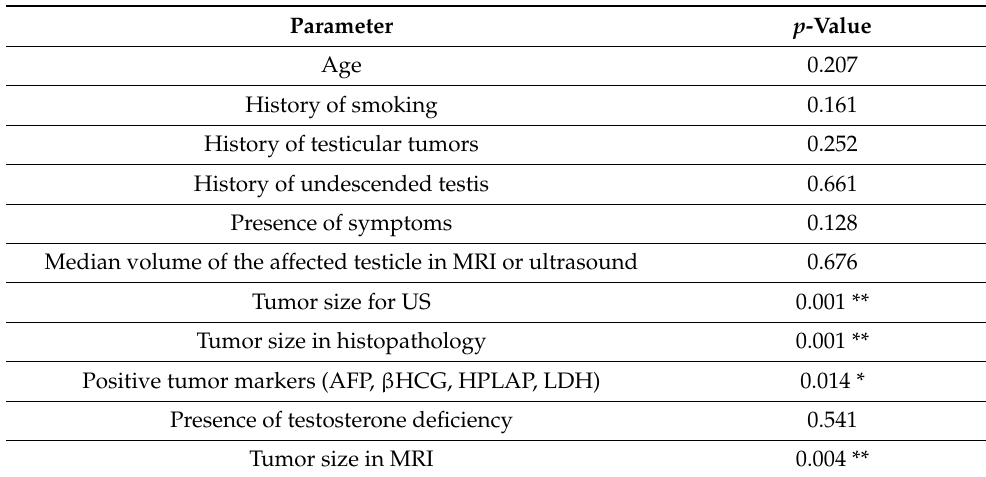
Table 4. Selected p -values comparing clinical and diagnostic parameters of the two subgroups